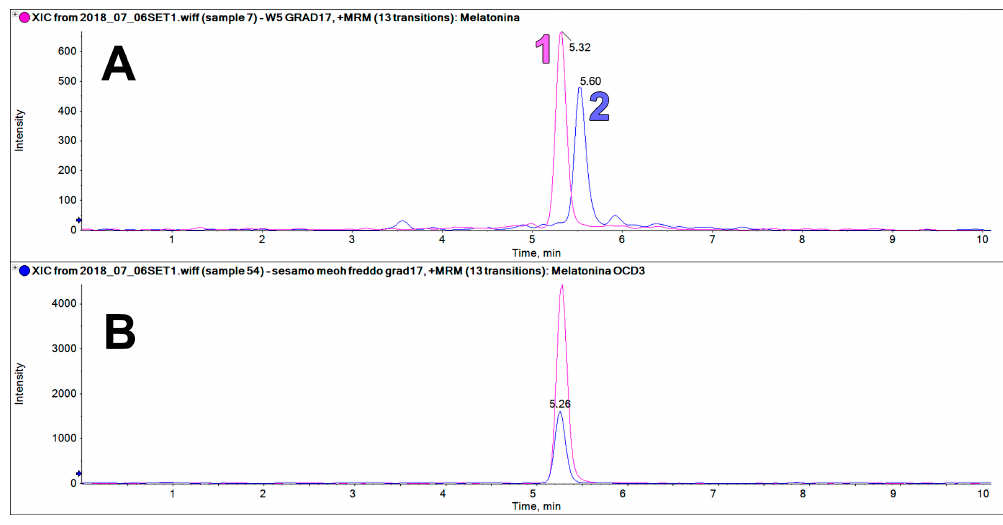
Figure 6. ( A ) LC-MS/MS analysis on the trace of MEL 233 > 174 m / z showing the peak of the MEL standard (1, RT 5.32, 62.5 ng/mL) and the peak of MEL isomers found in the sesame extract (2, RT 5.60). ( B ) LC-MS/MS analysis on the trace of MEL OCD3 (236 > 177 m / z ) showing similar ( B ) LC-MS / MS analysis on the trace of MEL OCD3 (236 > 177 m / z ) showing similar chromatographic chromatographic behavior to the MEL standard. behavior to the MEL